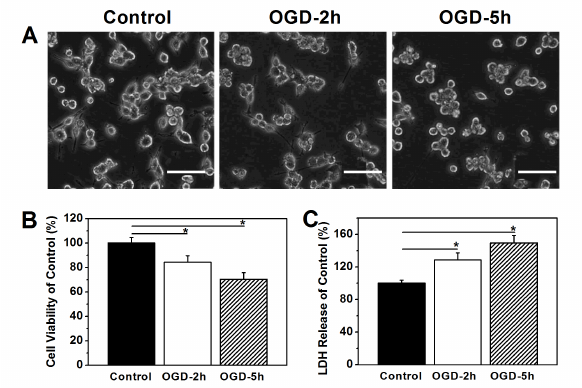
Figure 1. OGD treatment induced BV2 cell death. (A) Representative images of BV2 cells without or with OGD treatment. Scale bar = 200 µm. (B) Cell viabilities in control, OGD treated for 2 h or 5 h groups, examined by MTT assay. (C) OGD treatment increased LDH release in BV2 cells. Data were presented as mean ± S.E.M. *p < 0.05 vs control.